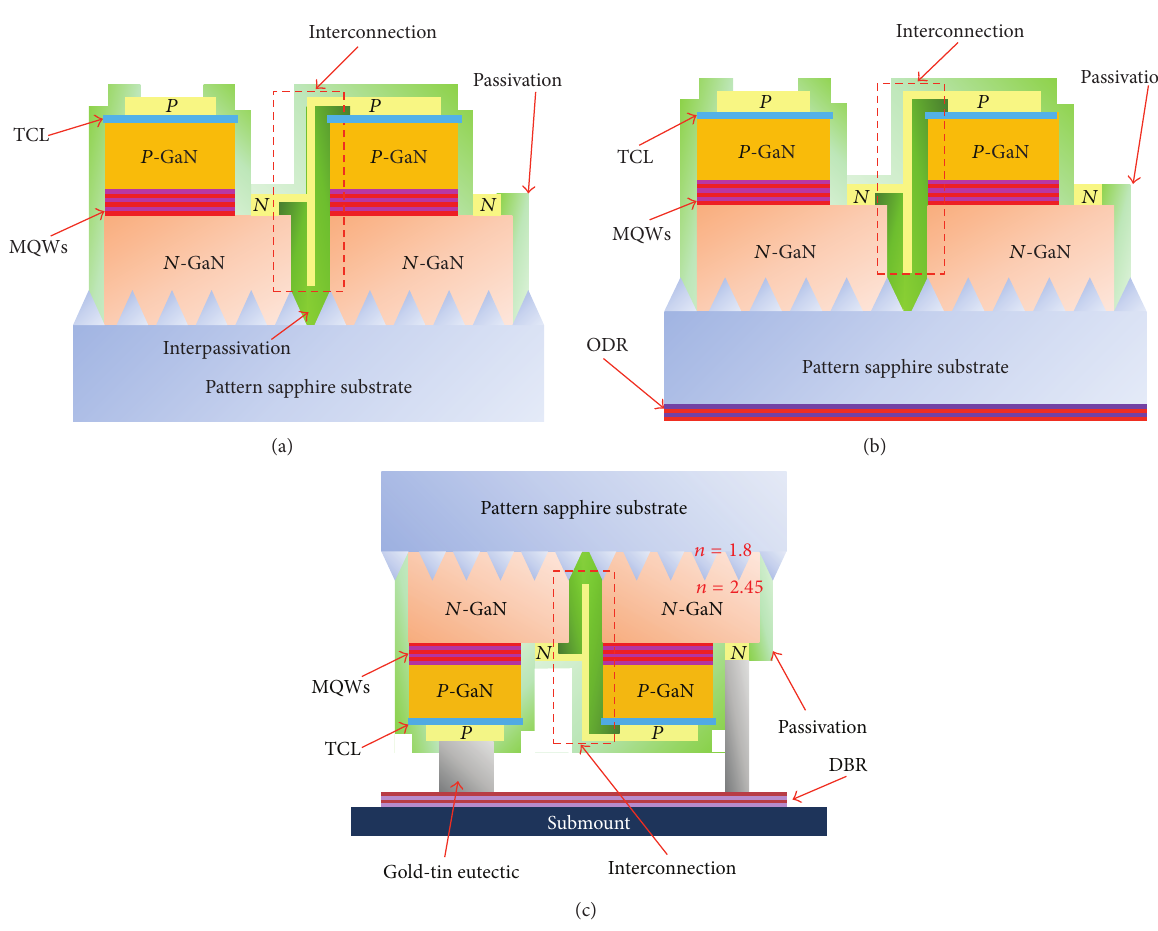
Figure 1: Schematic diagrams of (a) the conventional HV-LED, (b) HV-LED + ODR, and (c) high-voltage flip chip LED (HVFC-LED).